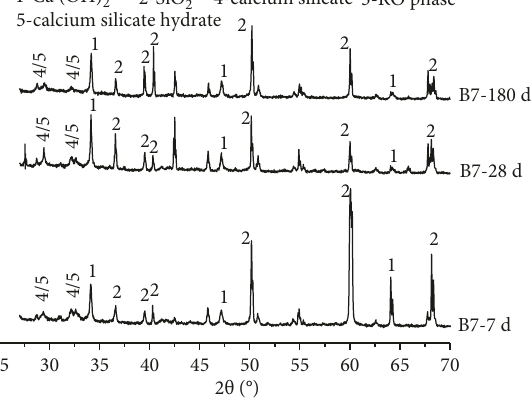
Figure 4: XRD patterns of the cement paste with 20% SSP.